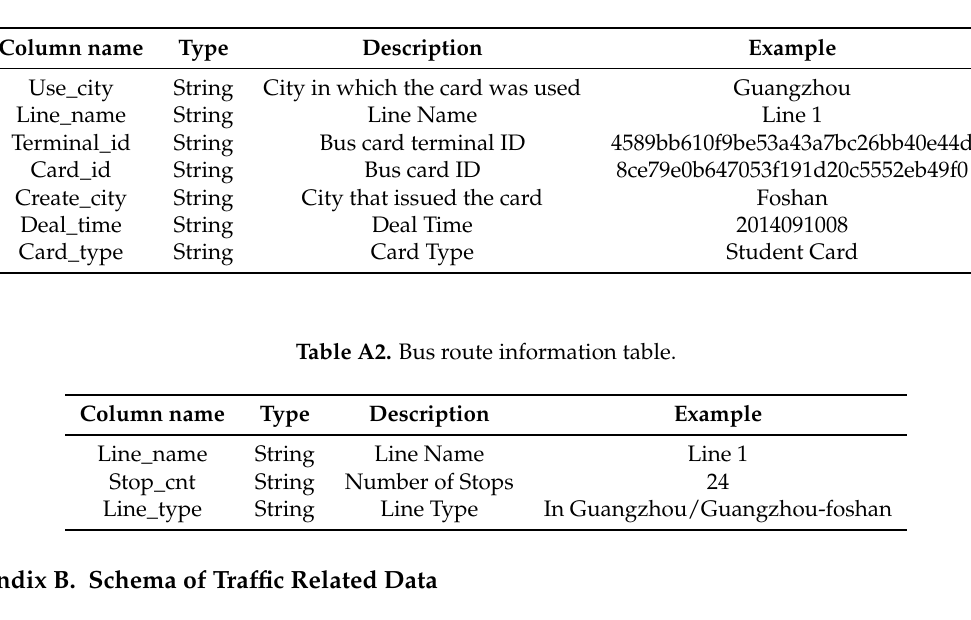
Table A1. Bus card transaction data sheet.